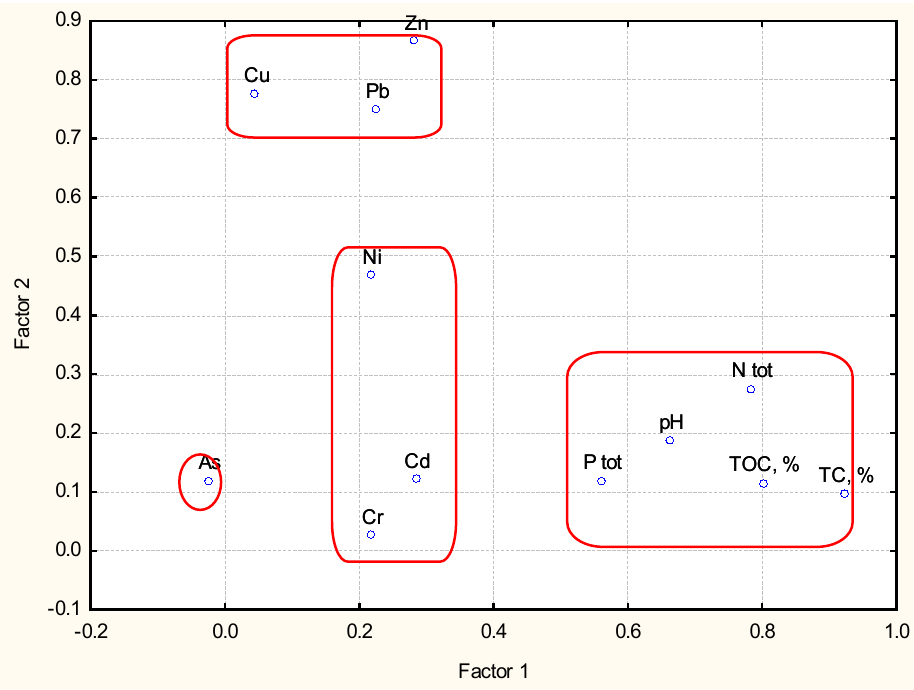
Figure 6: Biplot for factor loadings (PC 1 vs PC